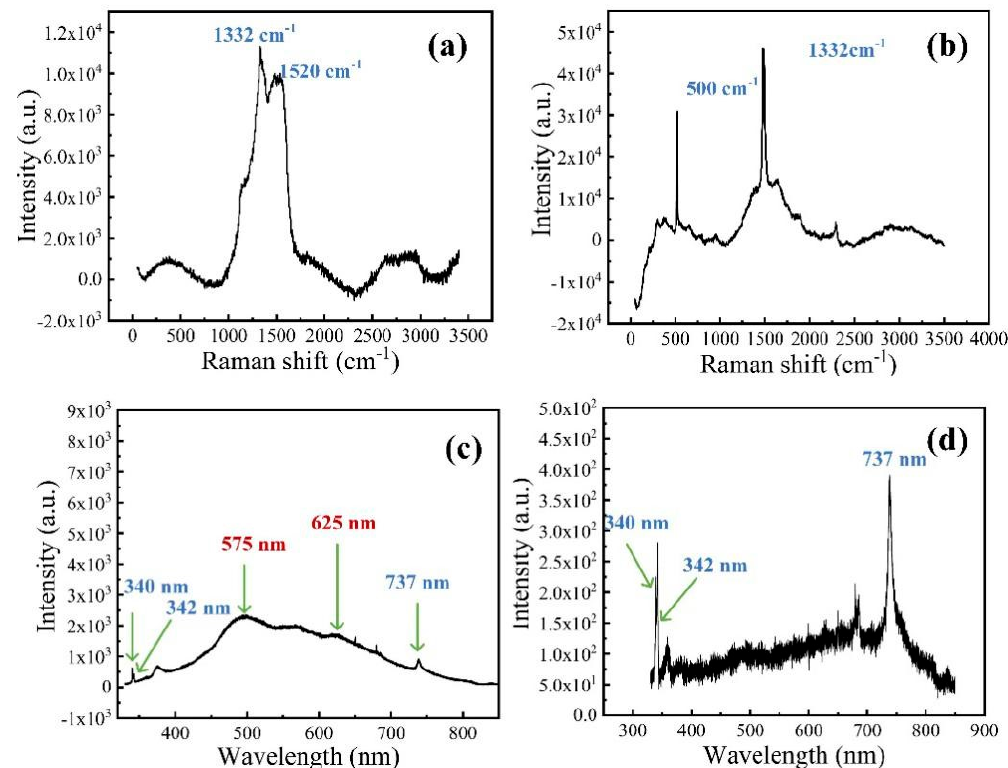
Figure 3. The Raman spectrum of ( a ) nitrogen-doped diamond film, ( b ) polycrystal diamond film. The PL spectrums with excitation at 325 nm of ( c ) nitrogen-doped diamond film and ( d ) polycrystal diamond film after photocatalysis.